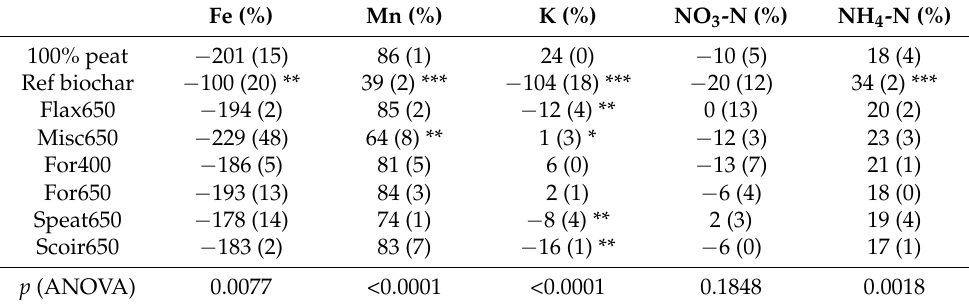
Table 4. Net relative accumulated mass of the elements in the leaching experiment as calculated by Equation (2) (average of two replicates with standard deviation in parentheses). Numbers are compared by ANOVA, and for the treatments with biochar compared with control treatment of pure limed peat by Dunnett (*: p < 0.05; **: p < 0.01; ***: p < 0.001). Codes of the biochars: See Table 1.